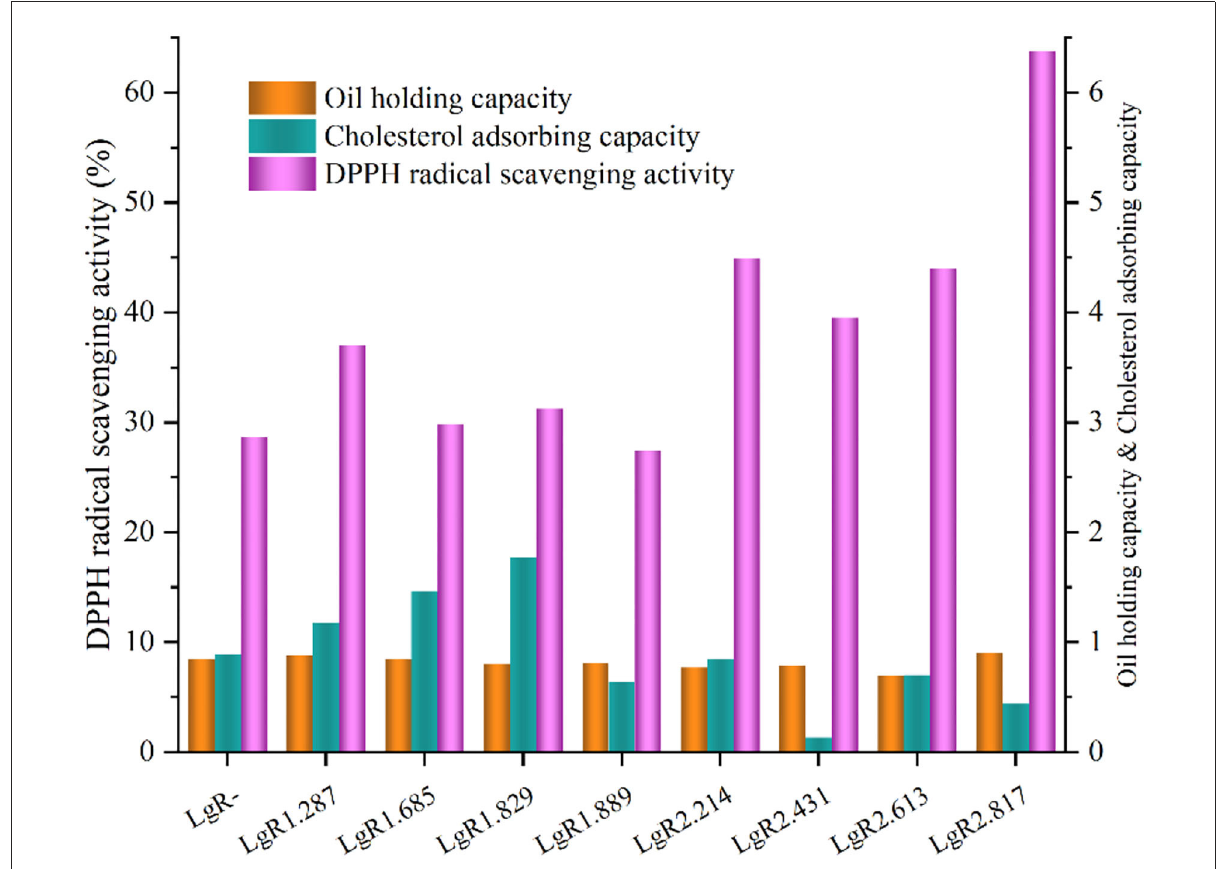
FIGURE5 Functional characteristics of soybean meal. LgR indicates the steam explosion